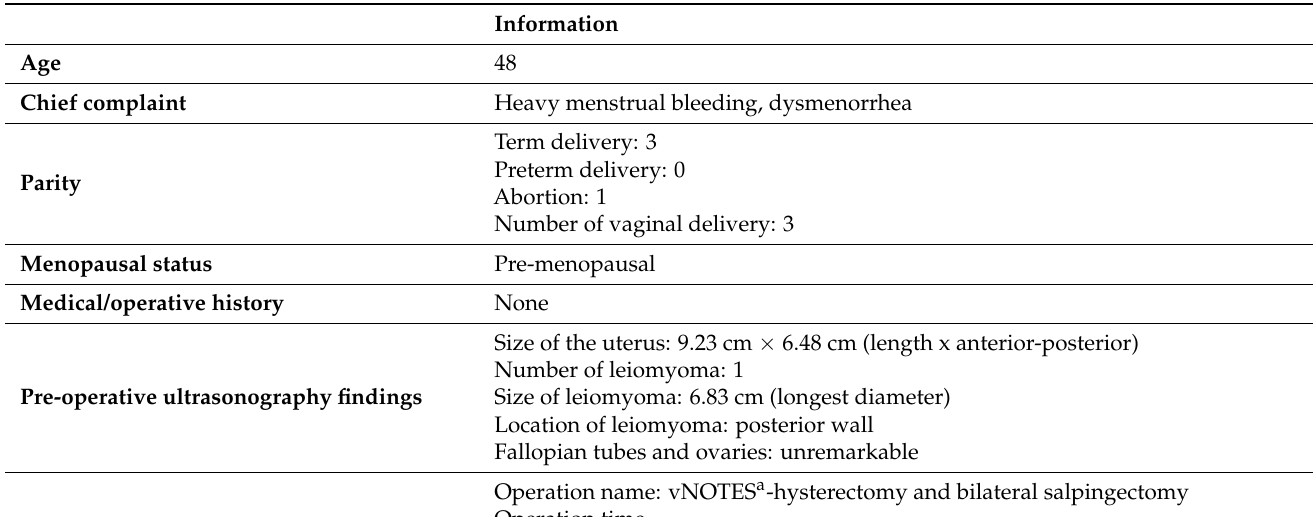
Table 4. Patient and surgical information of the ureteral injury case.